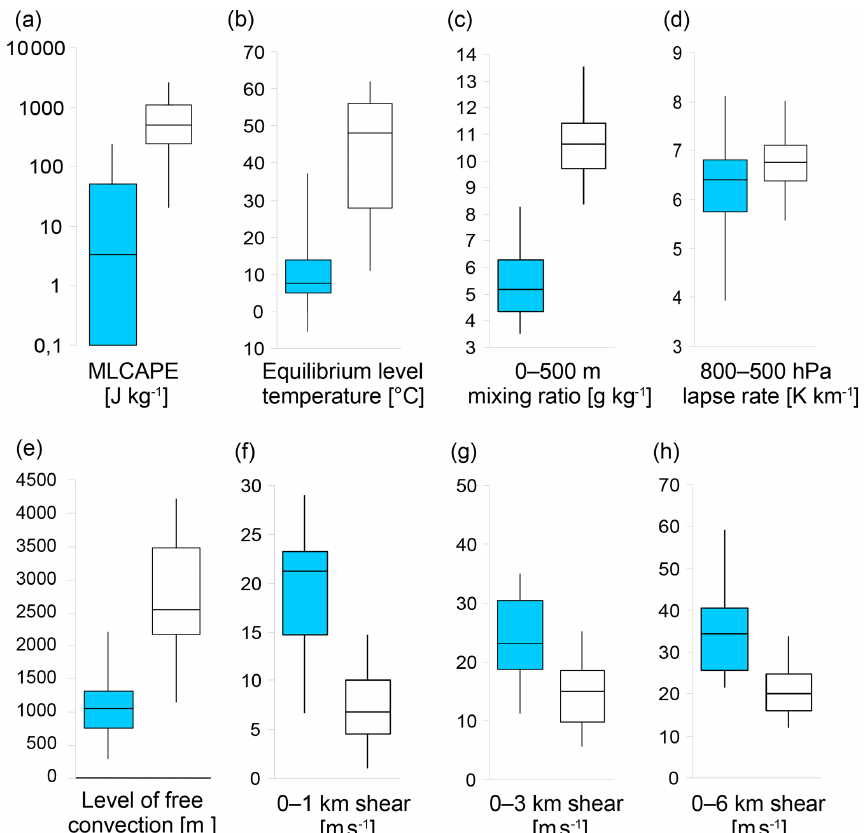
Figure 7. Box-and-whisker plots of warm-season-type and cold-season-type derecho proximity soundings (1997–2014). Boxes (blue for the cold-season type) give the upper and lower quartiles of the distributions, the end of the vertical thin lines give the maxima and minima, and the horizontal thick lines give the medians: (a) mixed-layer CAPE, (b) equilibrium level temperature, (c) 0–500m mixing ratio, (d) 800– 500hPa lapse rate, (e) level of free convection, (f) 0–1km vertical wind shear, (g) 0–3km vertical wind shear, and (h) 0–6km vertical wind